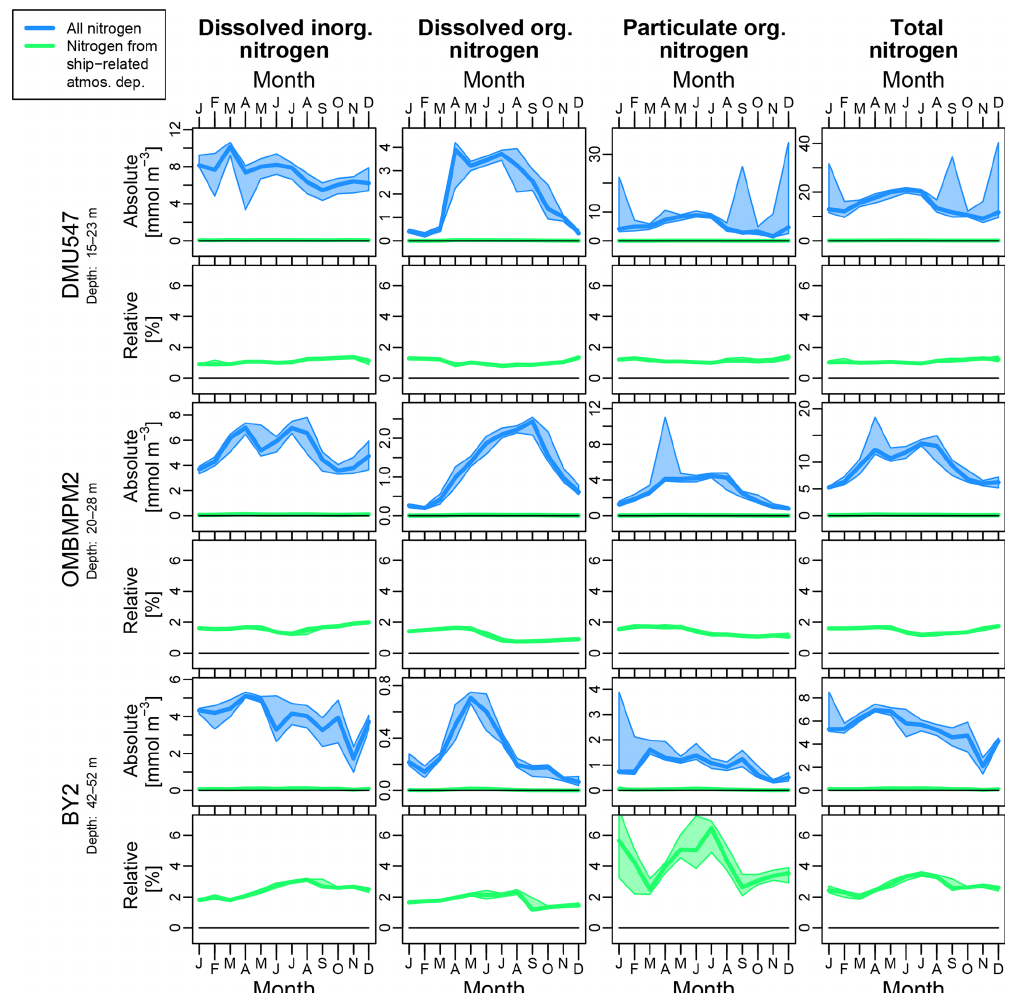
Figure 10. Similar to Fig. 9 but for the bottom 8 to 10m. The exact depth range is given on the left. A similar figure showing data at the other three stations is provided in the